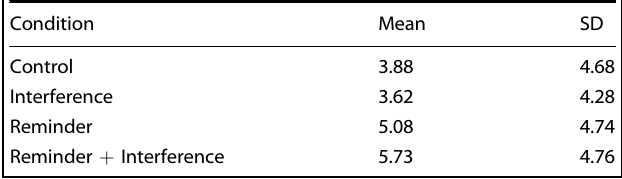
Table 4. Recall accuracy mean and SD scores in Experiment 2. Table 3. Simple effects analyses comparing conditions on percent